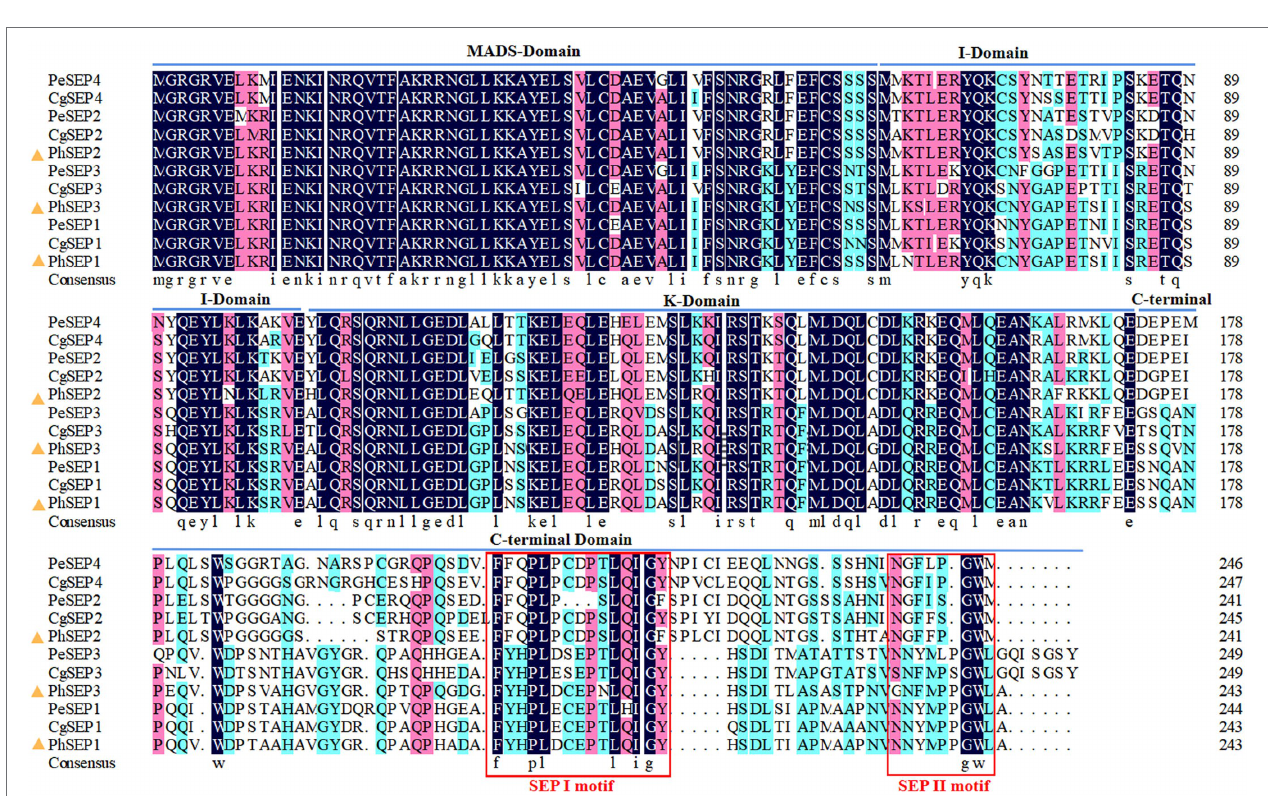
FIGURE 1 | Amplification of three PhSEP genes from Paphiopedilum henryanum.